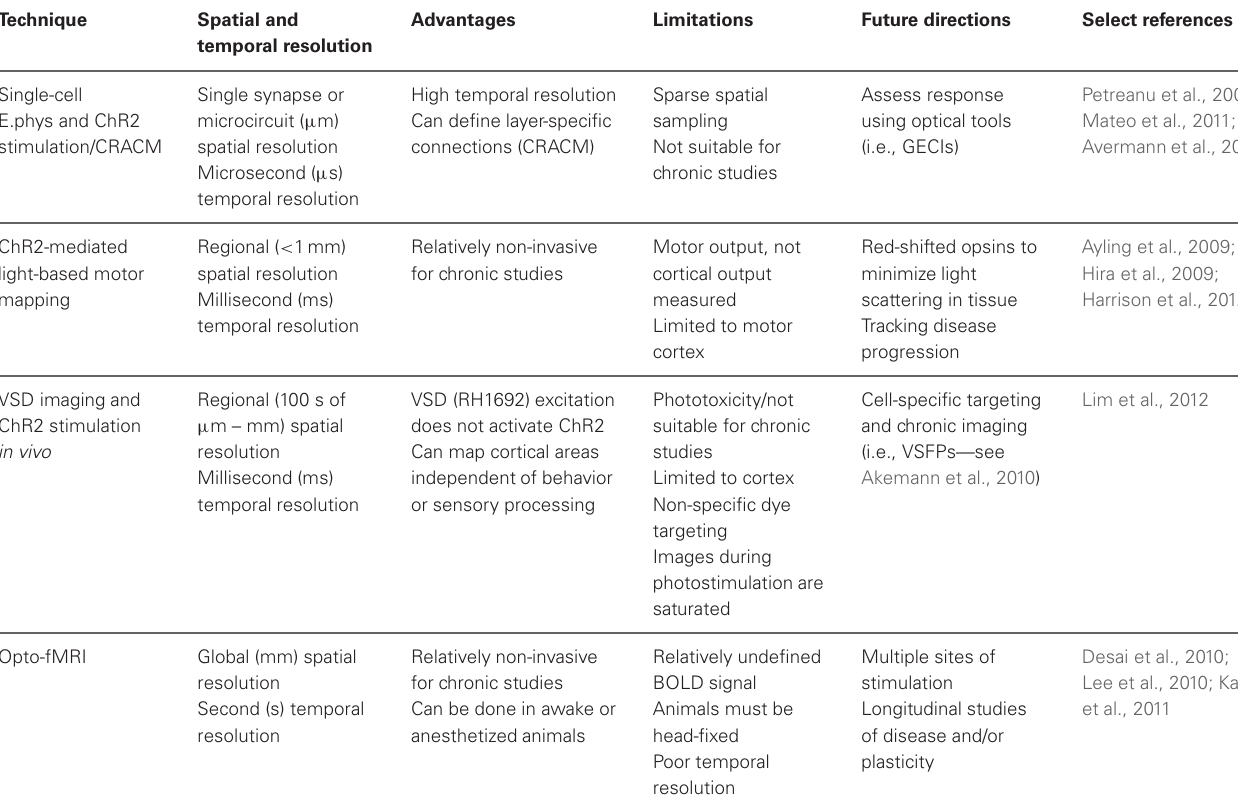
Table 1 | Optogenetic functional mapping